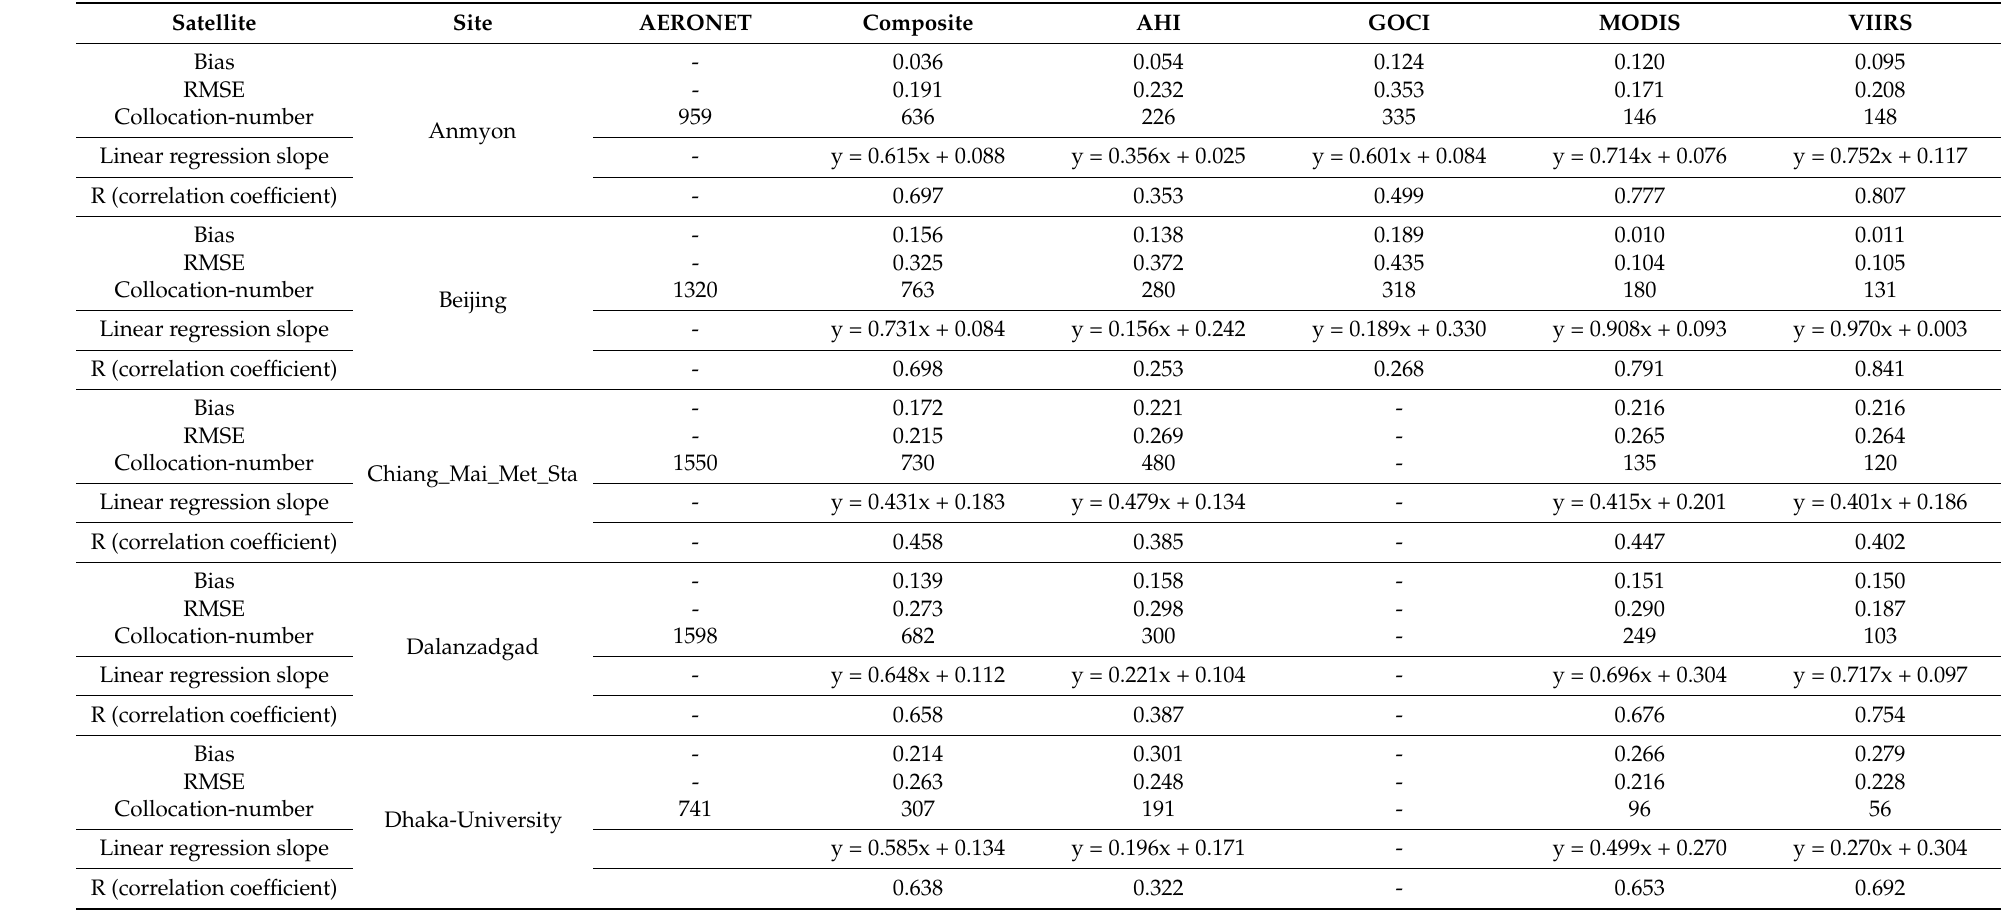
Table 4. Summary statistics for composite, satellites, and AERONET AOD products during